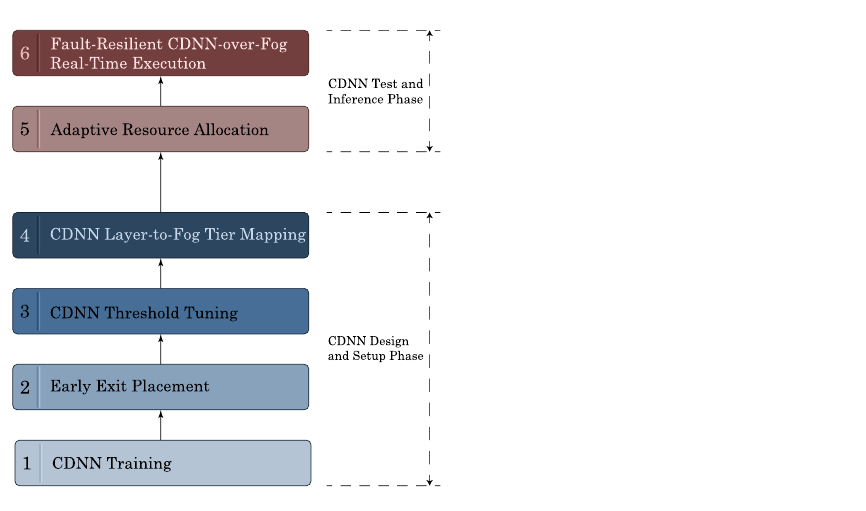
Figure 2. A sketch of the ordered steps sequence of the CDNN’s